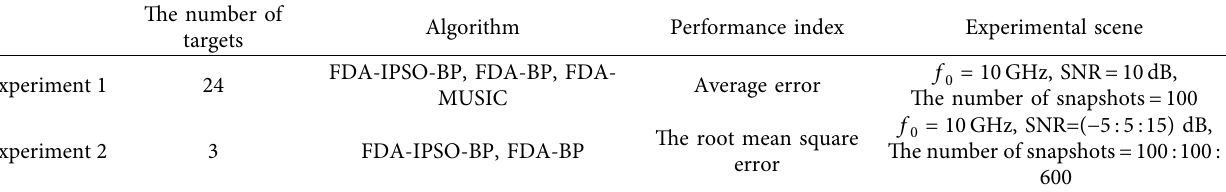
Table 1: The simulation experiments of target location.